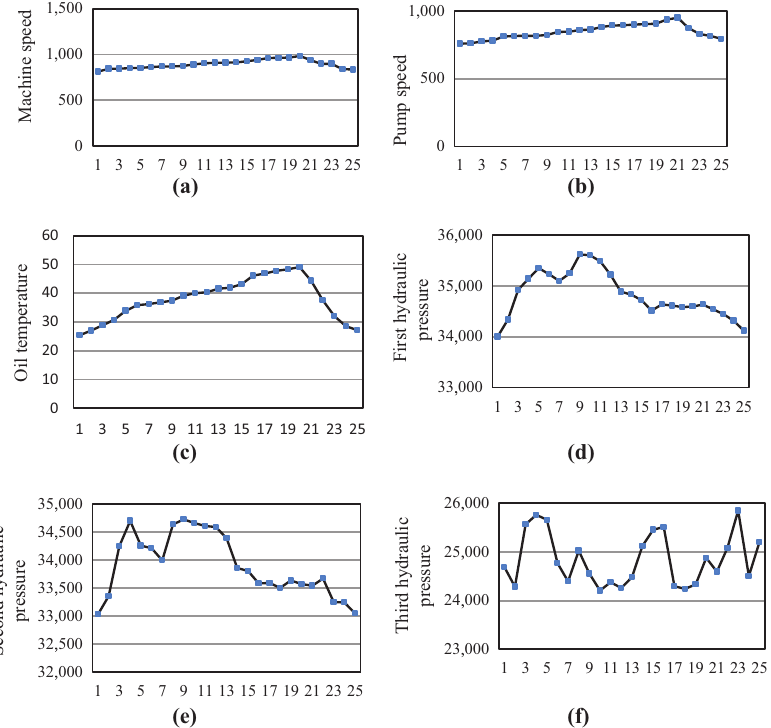
Figure 1. The group of monitoring data sequence from the